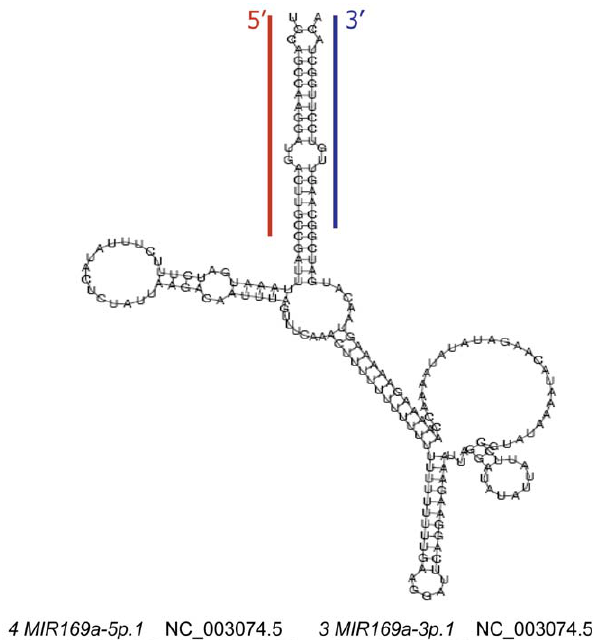
Figure 3. Predicted hairpin structure of miRNAs 3 and 4. miRNA 4 (red bar) and miRNA 3 (blue bar) target different genes and are encoded by complementary sequences within the stem-loop precursor. doi:10.1371/journal.pone.0010157.g003 PLoS ONE |